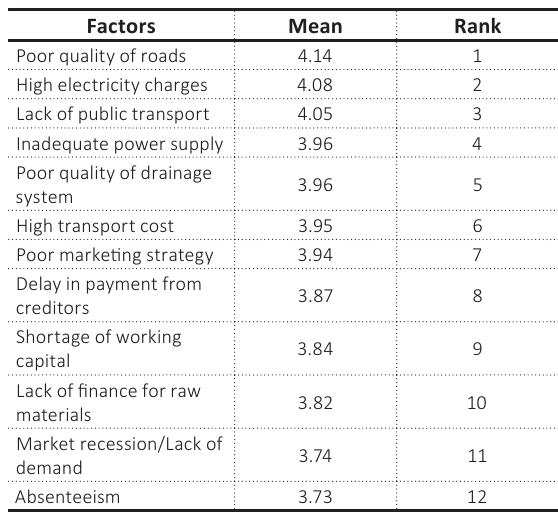
Table 15. Rank of major